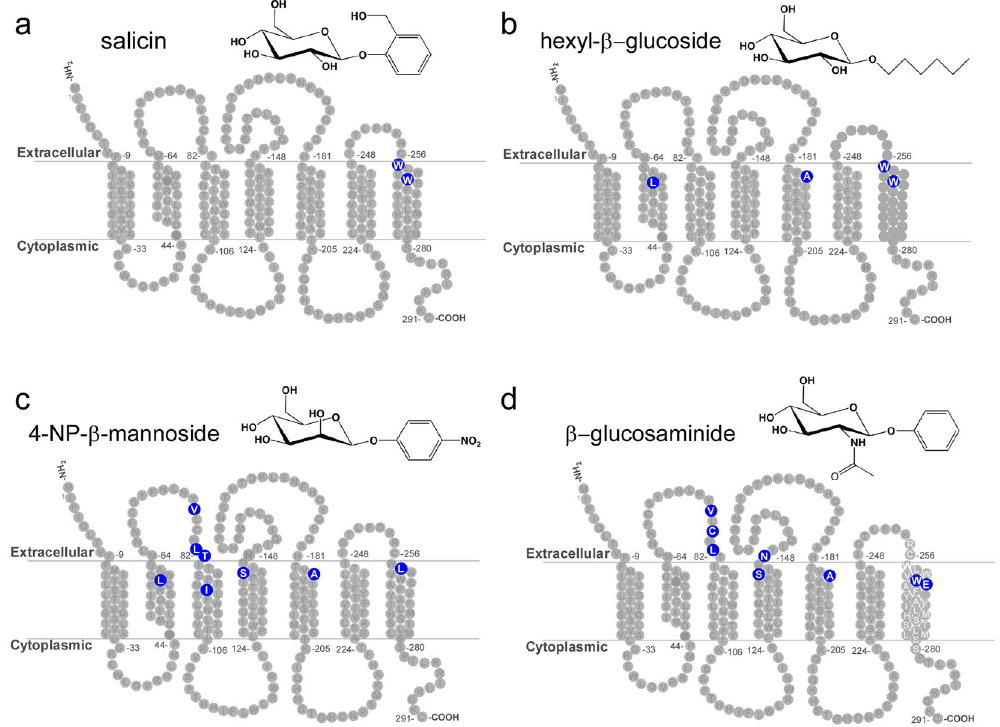
Figure 4. TAS2R16 residues that define ligand specificity. ( a–d ) Diagrams of TAS2R16 showing the locations of residues where mutations gave high activation with at least one ligand, low activation with another ligand, and > 2.5-fold differential response among ligands. Each panel shows residues (in blue) where a mutation resulted in decreased activation by the specific